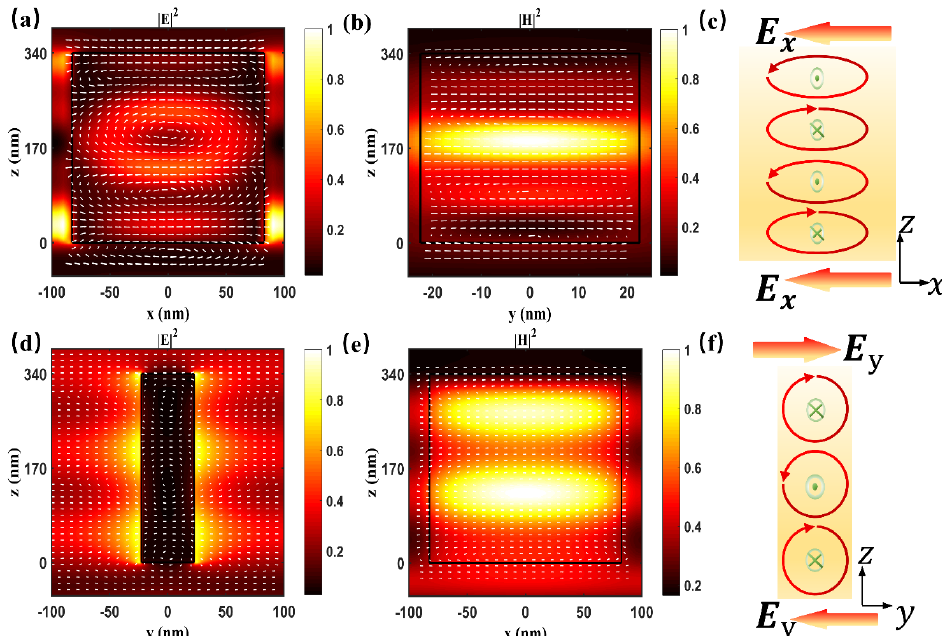
Figure 2. Excitation of anti-parallel magnetic dipoles (AMDs) in a Nb 2 O 5 nanobar. ( a , d ) Normalized total electric ( | E | 2 ) fields and ( b , e ) normalized total magnetic ( | H | 2 ) field existing in the optimized nanobar under 355 nm x - and y -polarized wave incidence, respectively. The white arrows denote the induced corresponding field’s vector profiles in and near the nanobar, and the black lines distinguish the boundaries of the nanobar. Simplified sketches of exited antiferromagnetic modes with even and odd dipoles are shown in ( c ) and ( f ), respectively.